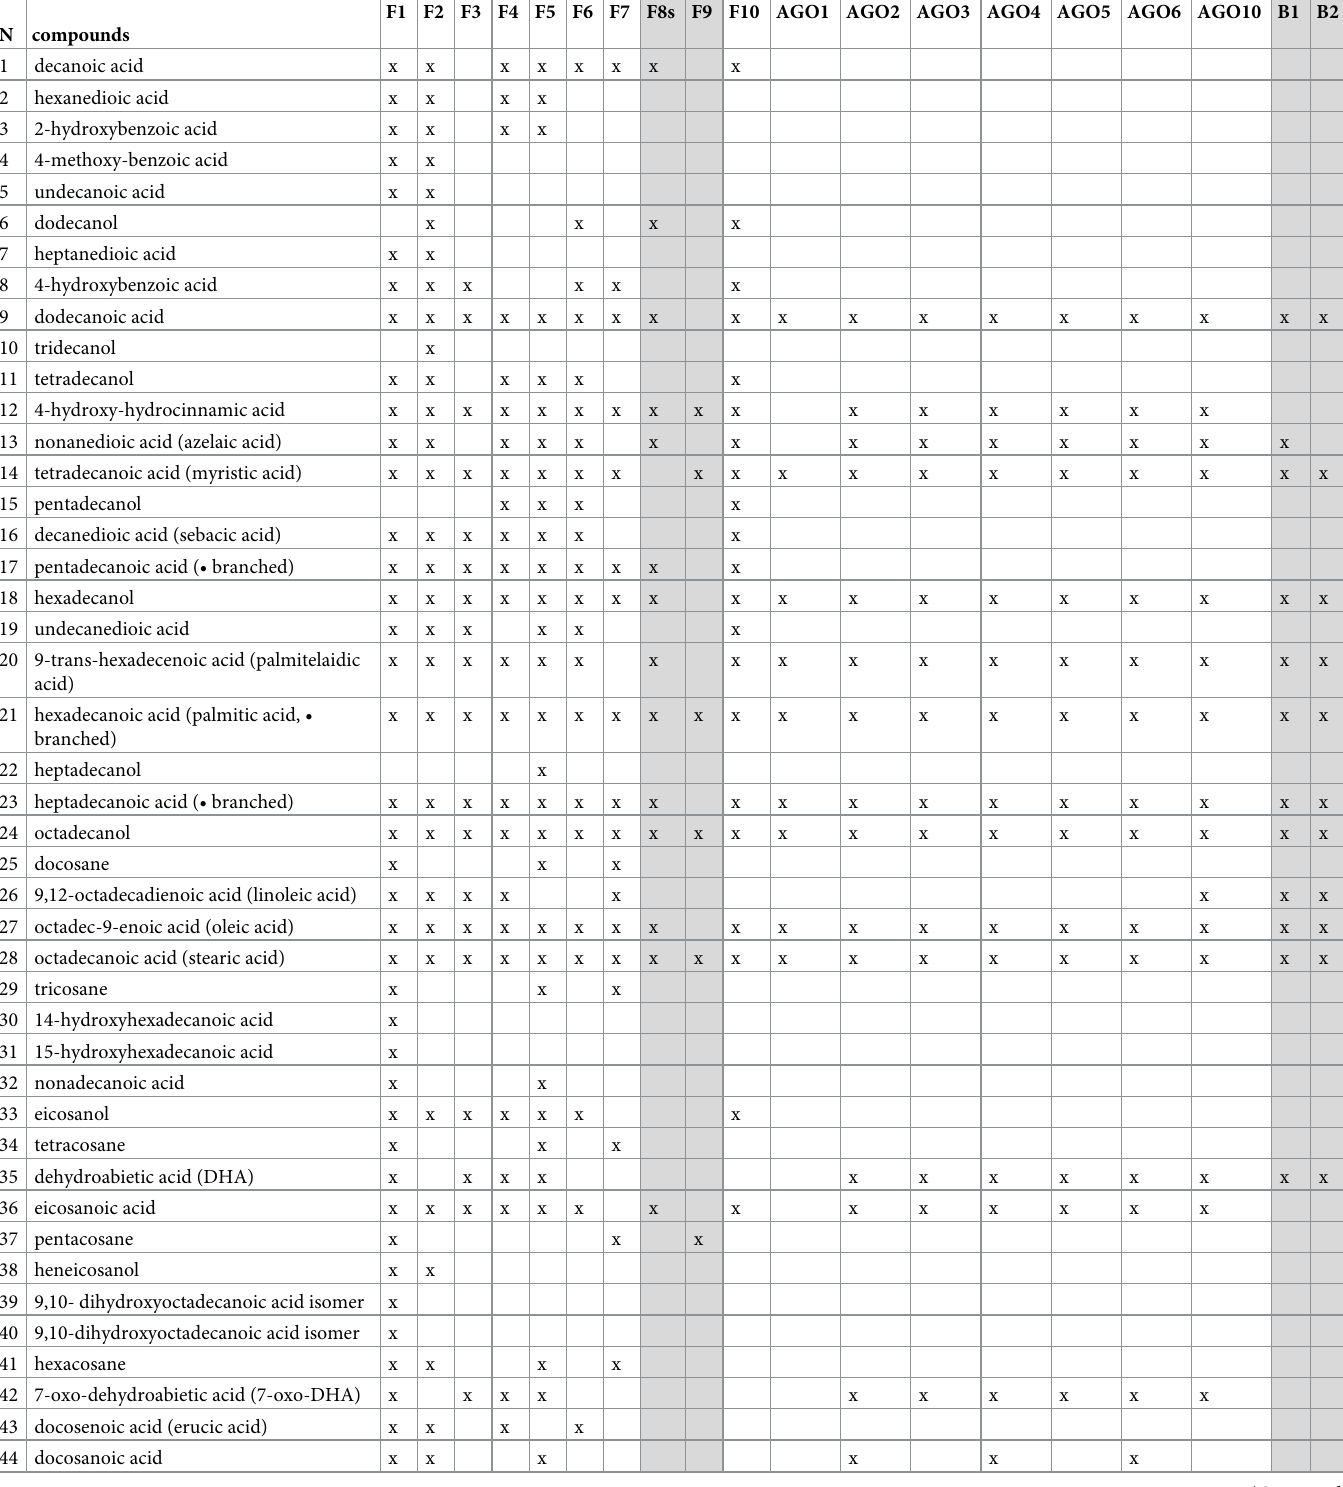
Table 8. List of compounds identified in the lipid-resinous fraction of the analyzed samples (the columns relative to the analytical blanks are highlighted in gray). Acids and alcohols are identified as their TMS derivatives. N compounds